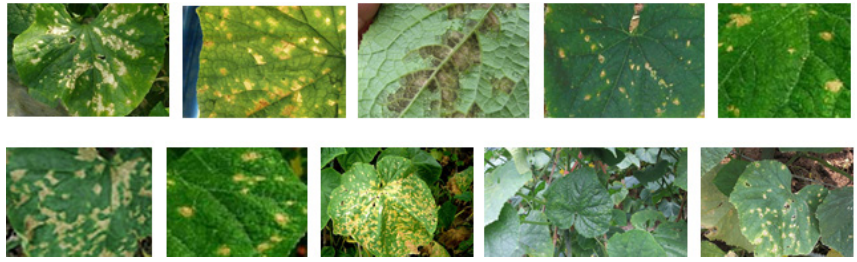
Figure 1. Disease leaf image examples.